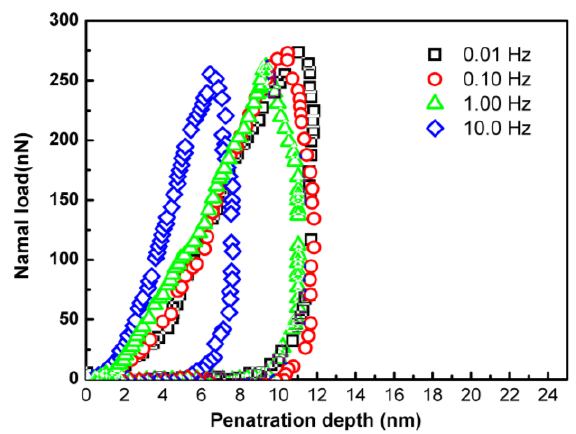
Figure 8. The force-penetration depth curves of nanoindentation at different penetration rate, the film thickness is 12.5 nm.